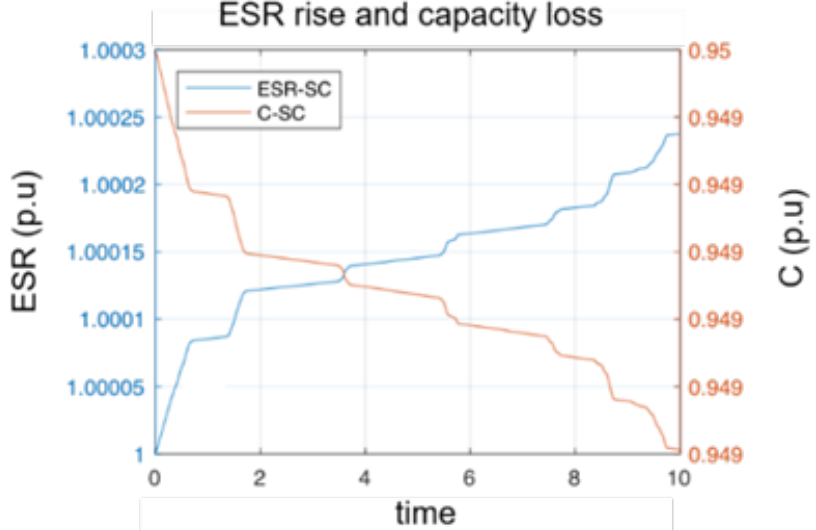
Figure 13. Capacity loss and ESR rise of the SCs.